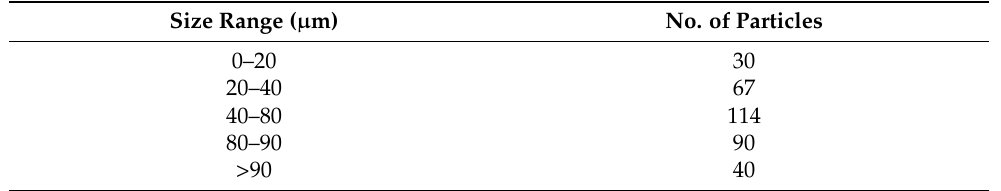
Table 4. Particle size analysis of TG.